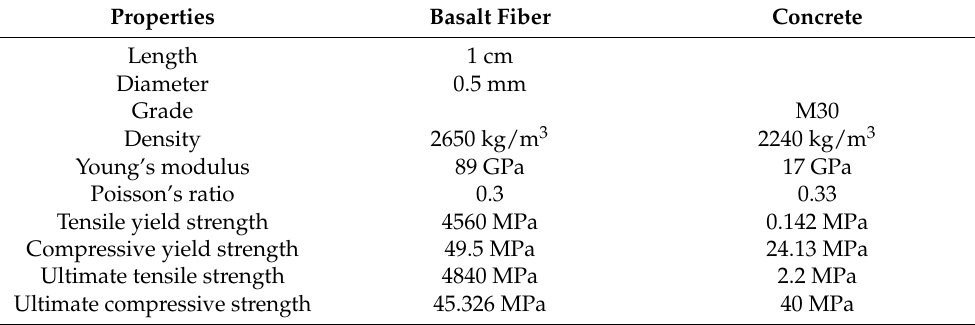
Table 1. Specifications of the basalt fiber and concrete used.